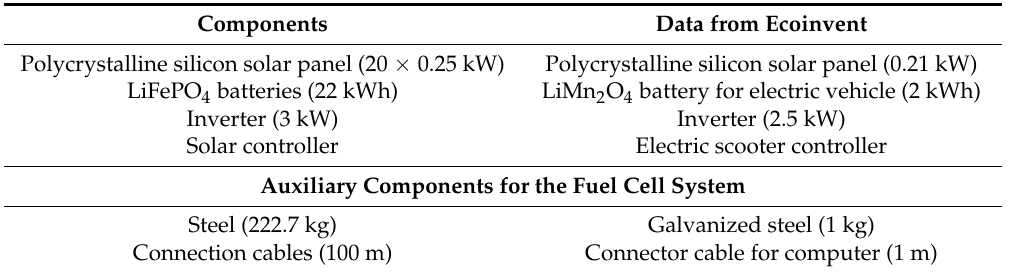
Table 4. Inventory for the battery-based